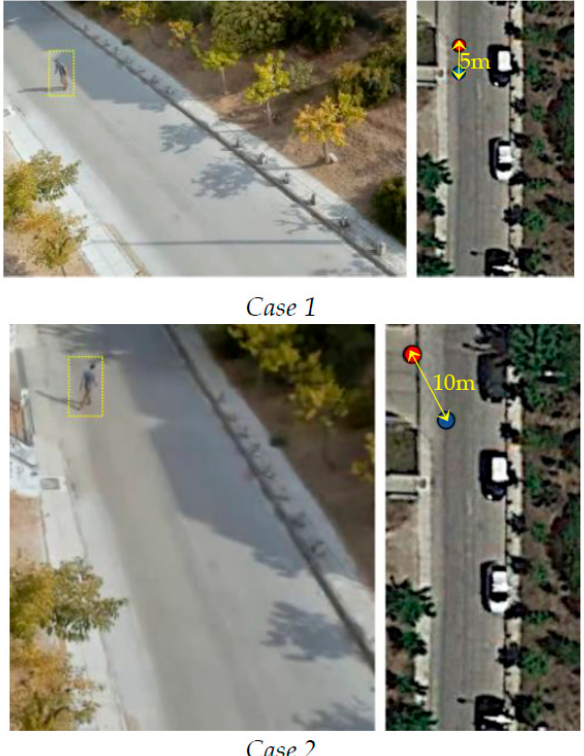
Figure 18. Examples of the calculated positions of a tracked object superimposed on Google Earth. The blue point indicates the real position of the object and the red point indicates the corresponding calculated position of the object through the localization module.